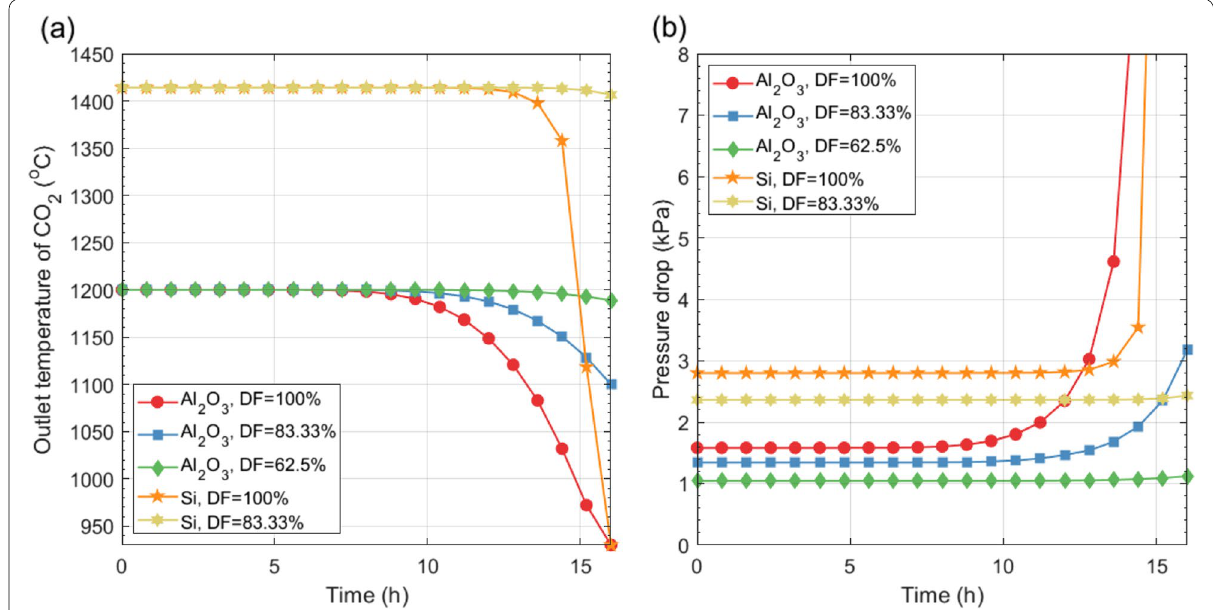
Fig. 5 a The outlet temperature of CO 2 stream and b pressure drop in the TES system for different TES materials and discharge